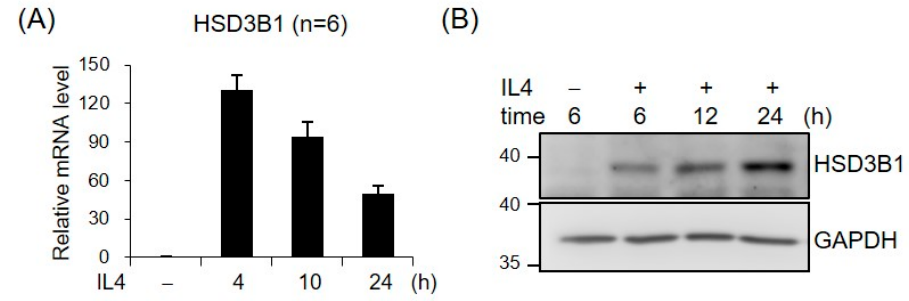
Figure 1. IL4 induces HSD3B1 expression in HT-29 cells. The HT-29 cells were treated with IL4 (20 ng/mL) for the indicated period. ( A ) RNA was extracted, and HSD3B1 mRNAs were quantified by real-time reverse transcription quantitative polymerase chain reaction (RT-qPCR). The values are represented as the means ± SEM of six independent experiments. ( B ) The cells were lysed and subject to immunoblotting for HSD3B1. GAPDH was used as the loading